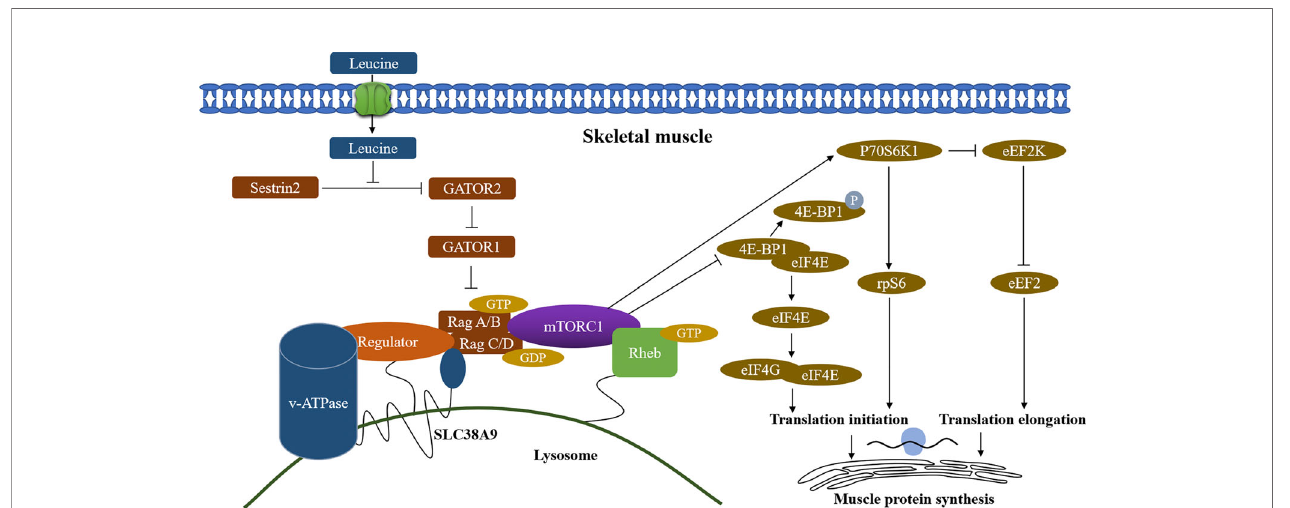
FIGURE 4 | Regulation of skeletal muscle protein synthesis by leucine. Sestrin2, stress response protein 2; GATOR1/2, GAP activity toward Rags 1/2; mTORC1, mammalian/mechanistic target of rapamycin complex 1; v-ATPase, vacuolar H+ -adenosine triphosphatase; Rag A/B C/D, RAS-related GTP-binding protein A/B C/D; SLC38A9, Solute Carrier Family 38 Member 9; 4E-BP1, 4E-binding protein 1; eIF4E, eukaryotic initiation factor 4E; eIF4G, eukaryotic initiation factor 4G; p70S6K1, p70 ribosomal protein S6 kinase 1; eEF2K, eukaryotic elongation factor 2 kinase; rpS6, ribosomal protein S6; eEF2, eukaryotic elongation factor 2; Arrows ( ↑ ) indicate stimulation and blocked lines ( ⊣ ) indicate